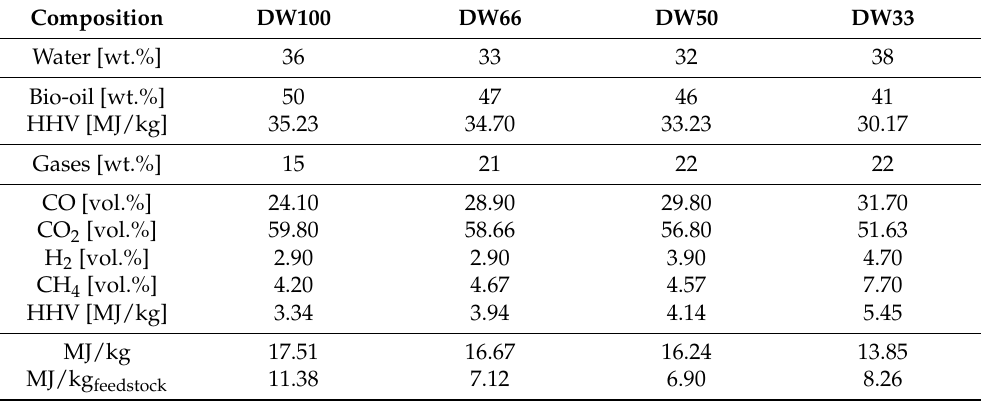
Table 3. Characteristic of pyrolysis gases for different distillery waste content in the pellets.